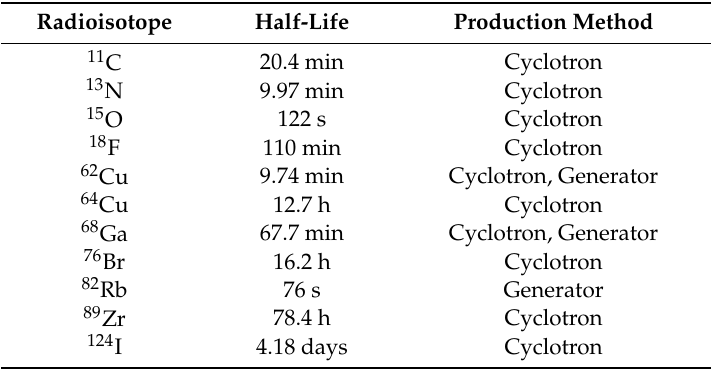
Table 1. Radioisotopes used in positron emission tomography